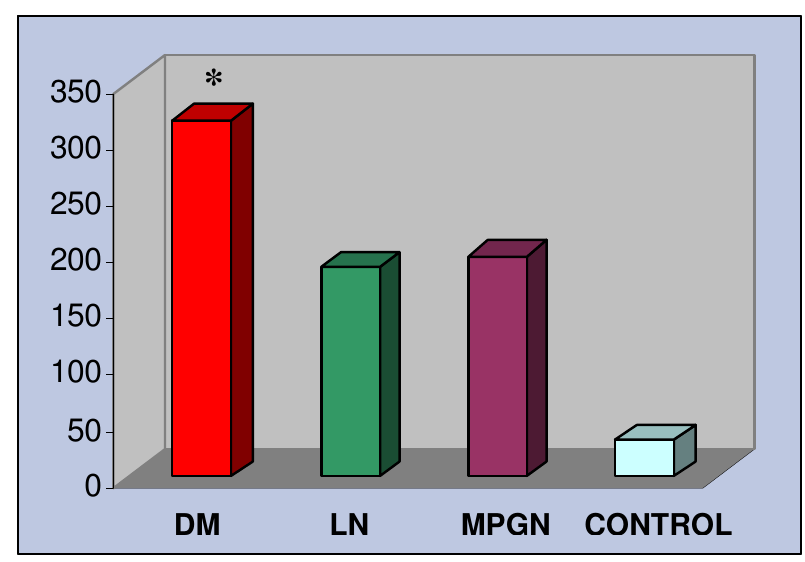
FIGURE 1. PKC α renal gene expression in the study groups ( µ g/ml). * p < 0.005 compared to MPGN and LN groups.